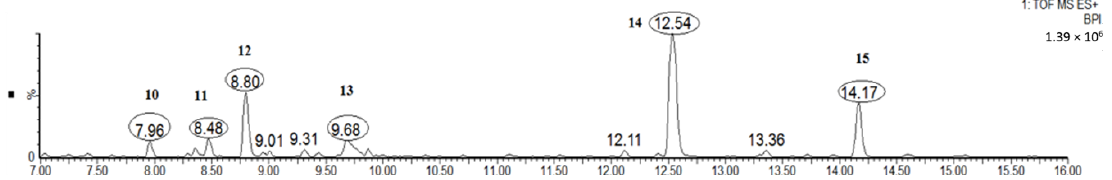
Figure 4. Product ion spectrum and proposed MS fragmentation mechanism of peak 5 in positive mode.